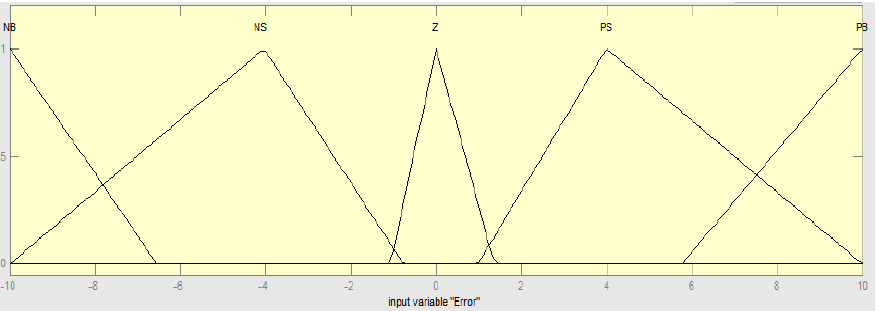
Figure 4. Structure of fuzzy logic controller.